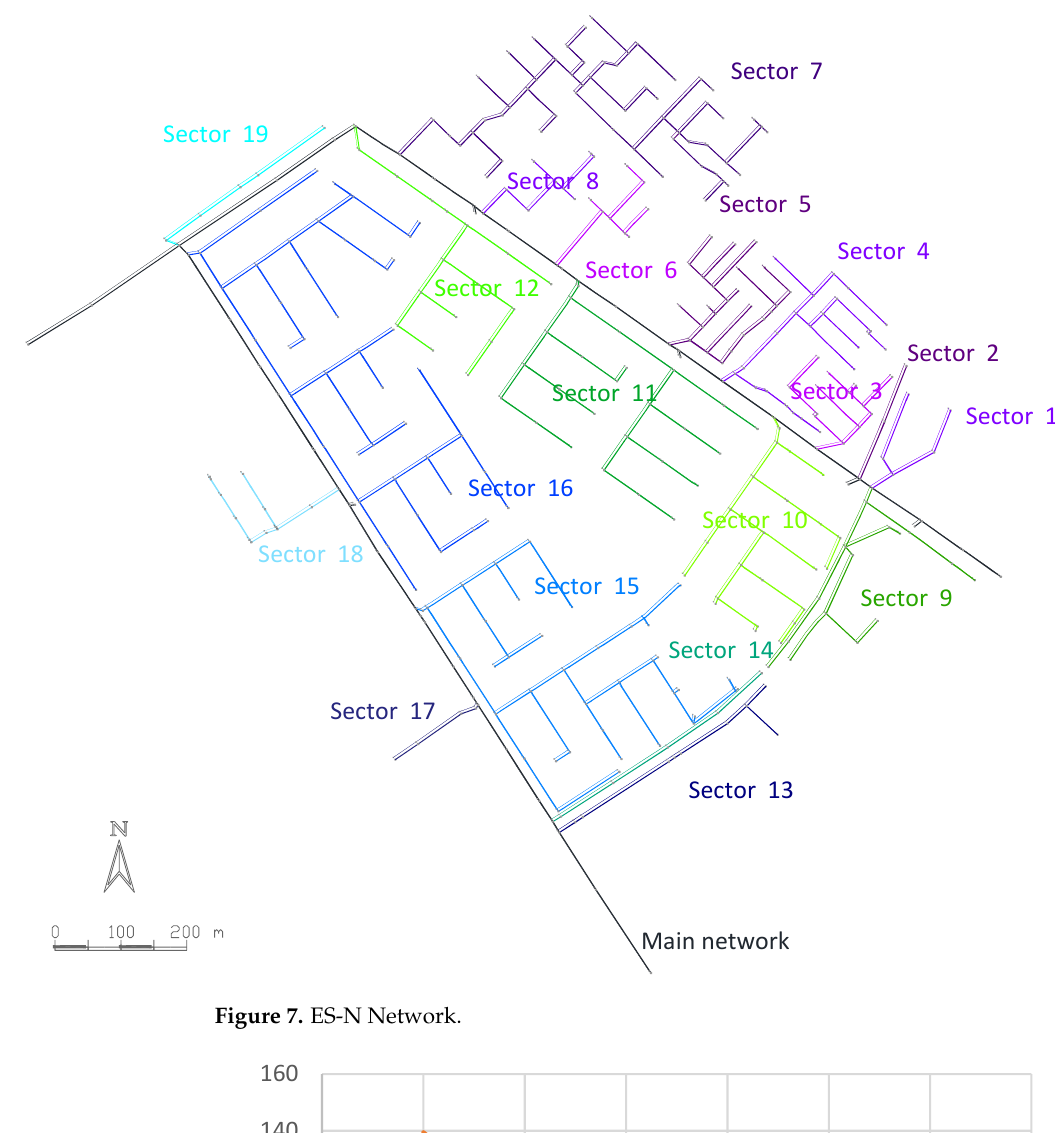
Figure 7. ES-N Network.